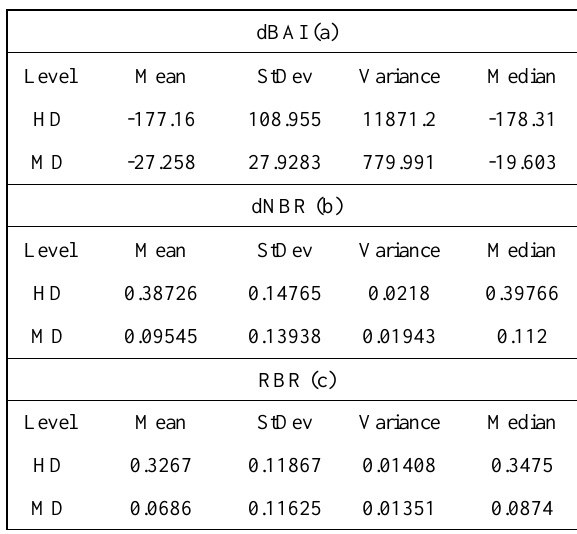
Table 3. Training dataset statistical variations: Differential Normalized Burn Ratio (a), the Relative Differenced Normalized Burn Ratio (b), and the Relativized Burn Ratio (c)